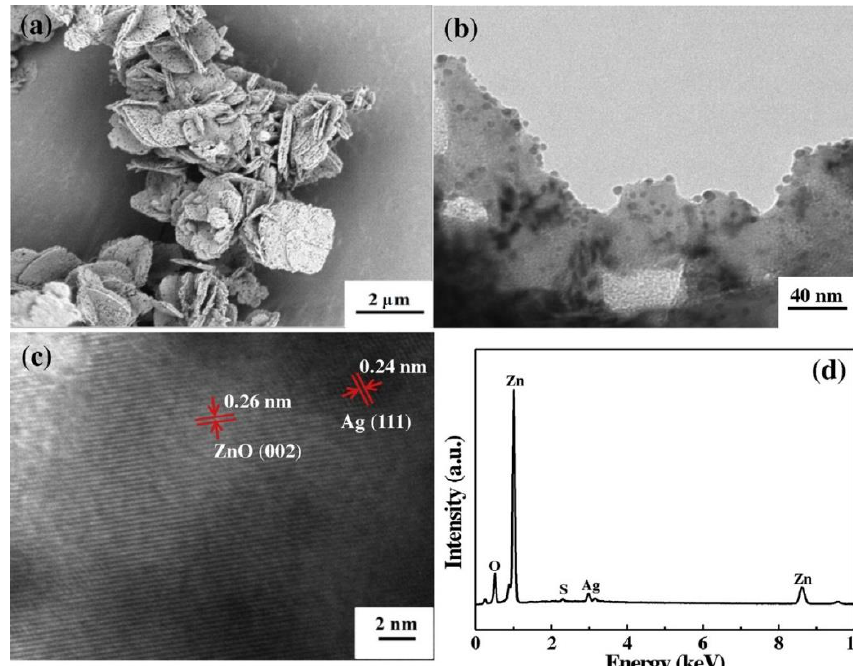
Figure 34. Figures should be placed in the main text near to the first time they are cited. A caption on a single line should be centered. ( a ) SEM image, ( b ) TEM image, ( c ) TEM image and ( d ) Energy dispersive spectroscopy (EDS) spectrum of Ag / Ag 2 SO 4 / ZnO nanostructures synthesised for ratio of thiourea and Ag + of 1:1. Reprinted from [736], Copyright (2015), with permission from Elsevier [OR